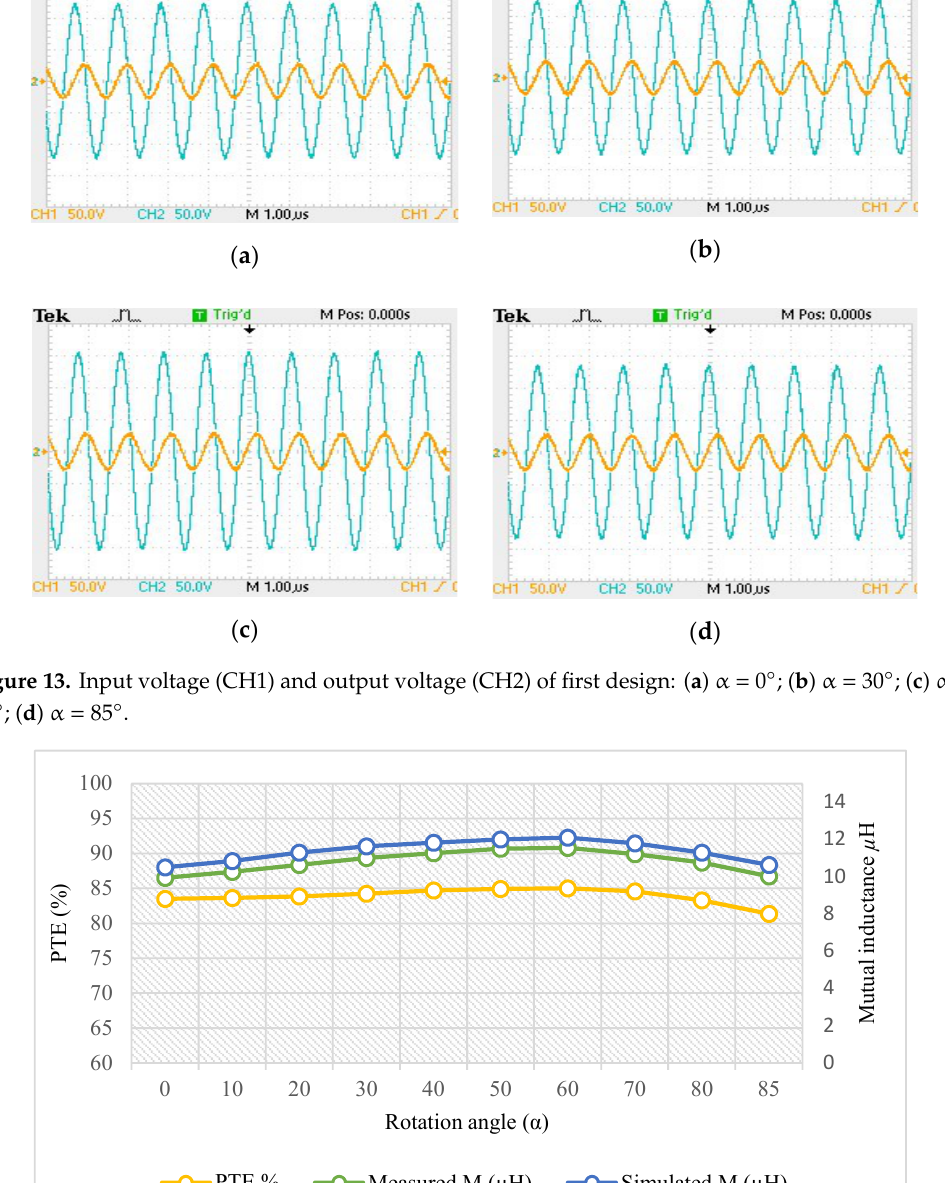
Figure 14. Simulated and measured mutual inductance, and efficiency according to rotation angle.